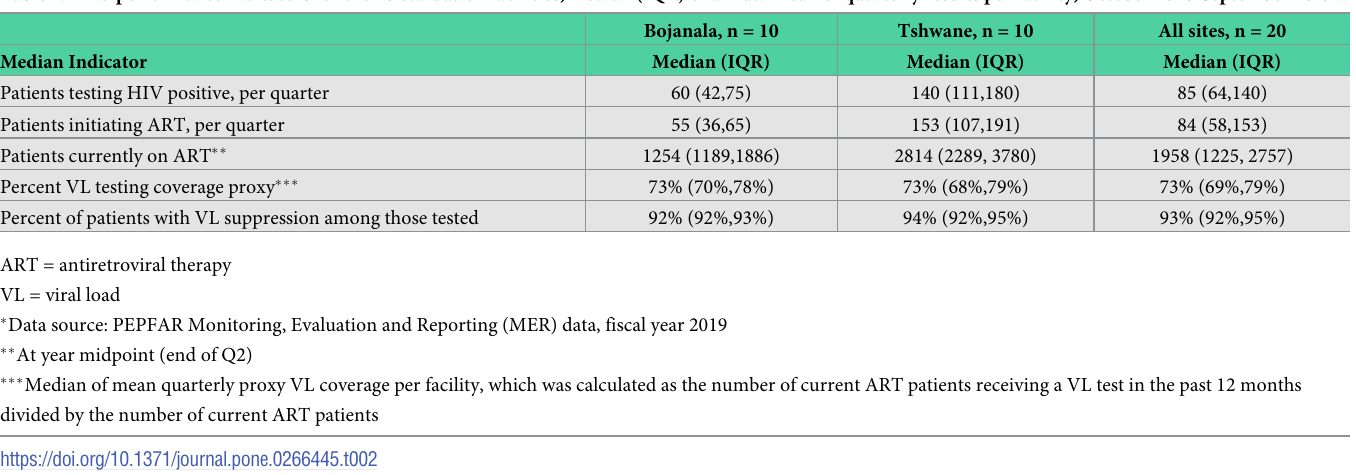
Table 2. HIV performance indicators for the 20 evaluation facilities, median (IQR) of annual mean of quarterly results per facility, October 2018-September 2019 � .